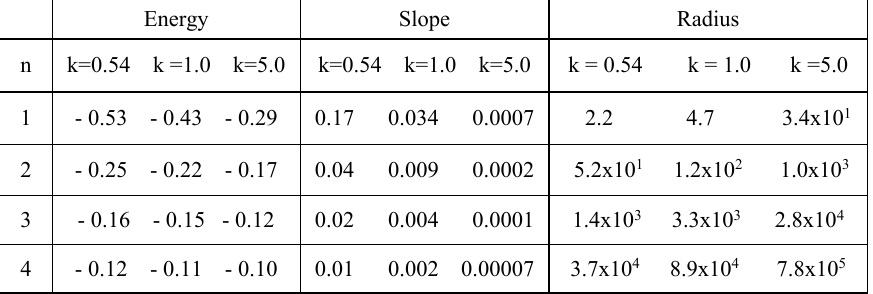
Table 3. Numerical results for eigenvalues, slopes and radii, with running-coupling constant and for different values of the IR cutoff k Energy